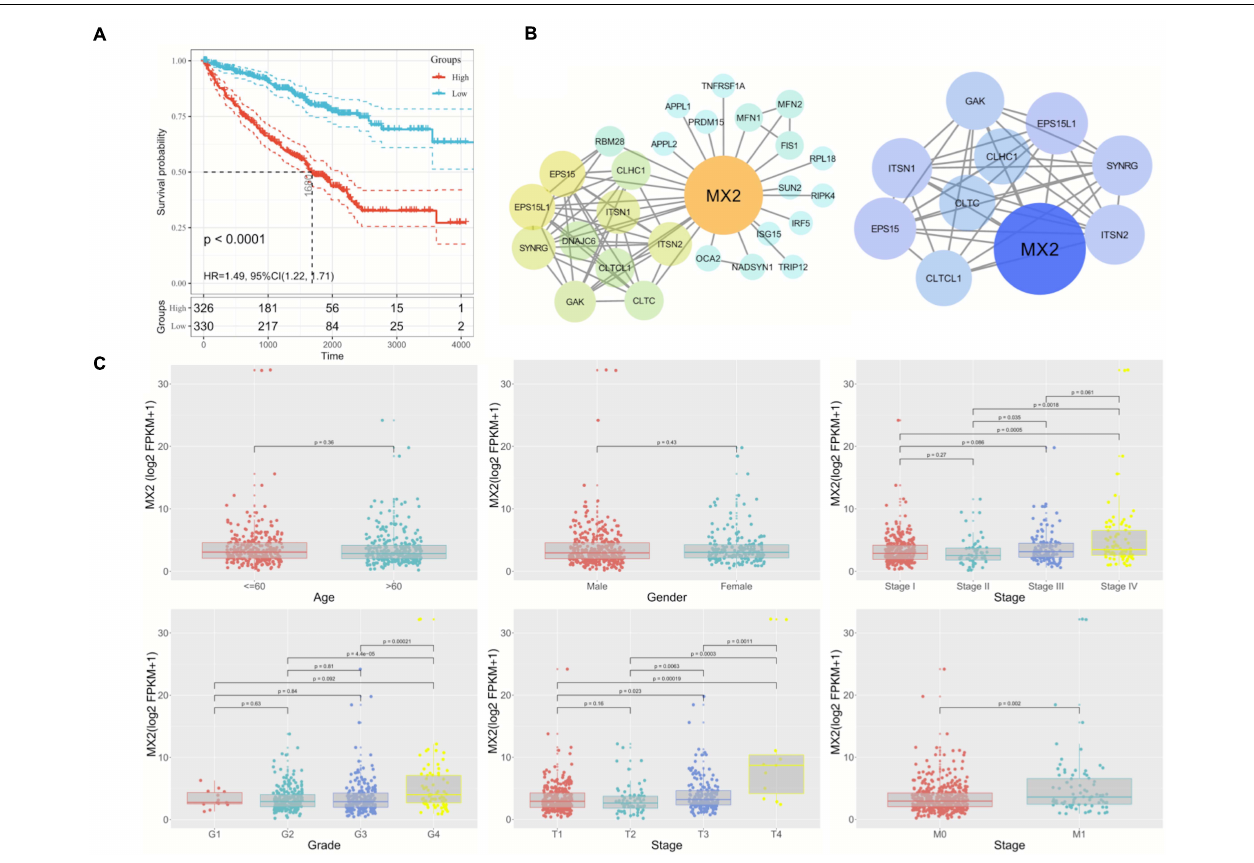
FIGURE 5 | Prominent clinical correlation of MX2. (A) Results of survival analysis on patients derived from KIRC, ICGC, and GSE29609. (B) PPI network of MX2 and top 10 nodes by STRING and Cytoscape. (C) The mRNA levels of MX2 in patients from TCGA database with various clinicopathological characteristics: gender, age, grade, T stage, M stage, and stage. Data differences were tested by one-way ANOVA. TCGA, The Cancer Genome Atlas; ICGC, International Cancer Genome Consortium.